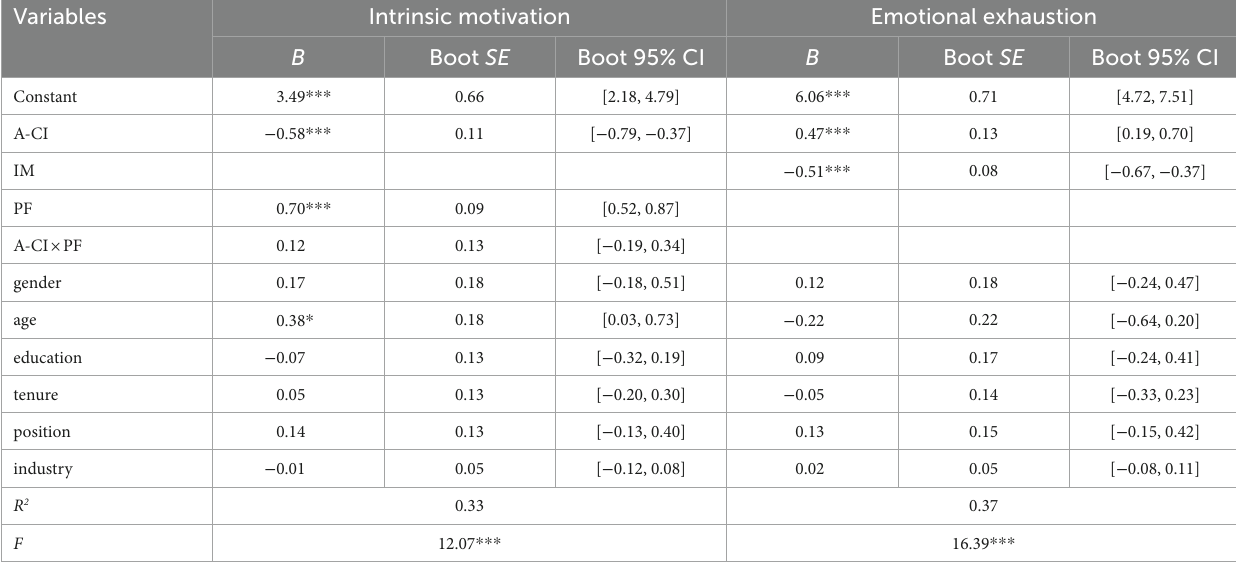
TABLE 4 Regression coefficient estimates of active cyber incivility in Study